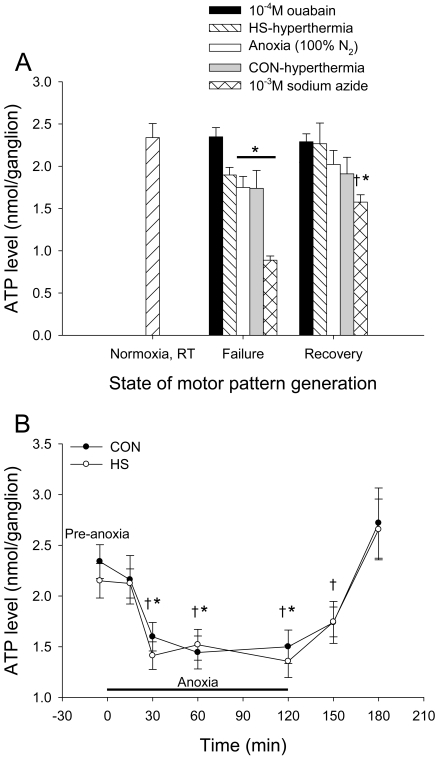
Failure and recovery of the CPG are not dependent on MTG ATP and HS preconditioning does not confer protection by improving ATP availability.A. ATP levels did not differ from the pre-stress level (Normoxia at room temperature; N = 16) in locusts treated with 10−4 M ouabain or hyperthermia (HS) at failure or recovery, or in all other groups at recovery following stress-induced failure with the exception of NaN3-treated locusts. There was a main effect of treatment driven by significant differences among groups within failure and recovery (not indicated by symbols). There was no effect of HS pre-treatment on ATP levels at failure or recovery of motor pattern generation. Asterisks indicate significant differences from the pre-stress level and daggers indicate significantly different ATP levels at failure and recovery in ganglia of NaN3-treated locusts. Sample sizes (failure, recovery): NOuabain = 10,11; NHS-hyperthermia = 8,8; NAnoxia = 9,8; NCON-hyperthermia = 7,7; NSodium azide = 8,9. B. CON and HS locusts did not have significantly different ATP levels during anoxia-induced coma or subsequent recovery. ATP levels dropped in both CON and HS locusts after 30 minutes of anoxia and remained stable until locusts were removed from the anoxic environment. ATP levels increased to around pre-anoxia values after one hour in normally oxygenated air. Sample sizes (CON, HS): N0min = 16,16; N15min = 12,11; N30min = 11,11; N60min = 9,9; N120min = 12,11; N150min = 11,12; N180min = 10,10. Asterisks indicate significant differences from 0 and 15 minutes and daggers indicate significant differences from 180 minutes (or 60 minutes recovery) according to post hoc Tukey tests (P<0.05).